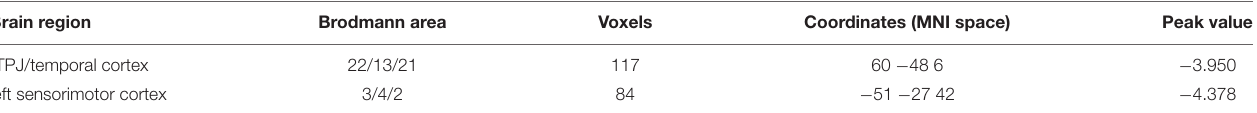
TABLE 1 | Brain regions with significant ReHo difference between CSNP patients and health controls. rTPJ, right temporo-parietal junction. Brain region Brodmann area Voxels Coordinates (MNI space) Peak value rTPJ/temporal cortex 22/13/21 117 60 − 48 6 − 3.950 left sensorimotor cortex 3/4/2 84 − 51 − 27 42 −